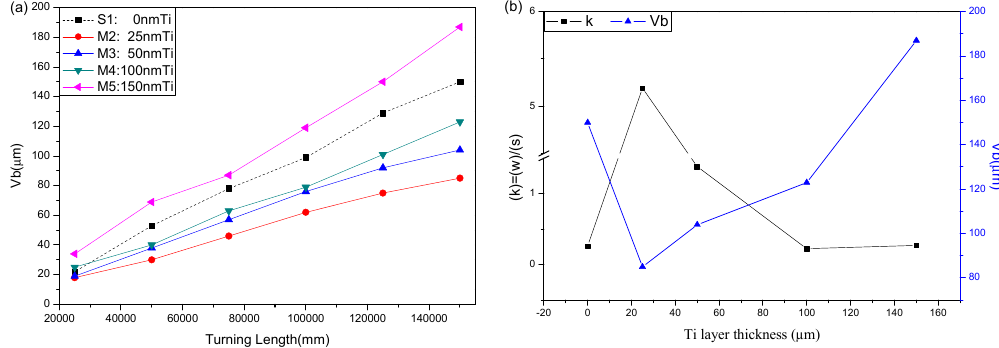
Figure 11. ( a )Tool flank wear Vb curve versus cutting length of different coated tools. ( b ) Tool flank wear Vb and length ratio k curve versus Ti layers thickness of different coated tools, k = W/S = ∑ ( w )/ ∑ ( s ).